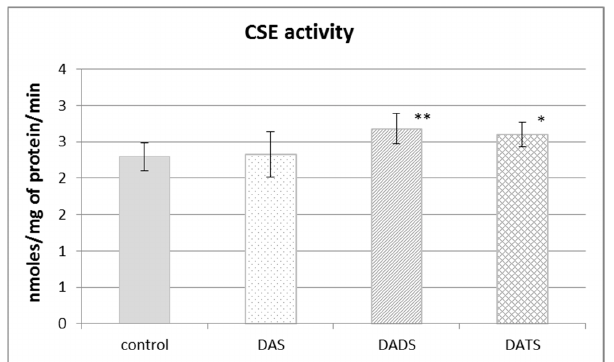
Figure 2. The effect of garlic-derived allyl sulfides (DAS, DADS and DATS) on the activity of γ -cystathionase (CSE). Data represent the means of six animals in each group ± SD and are expressed as nmoles per 1 mg of protein per minute. Each assay was performed in triplicate. Statistically significant differences were determined by ANOVA followed by the Fisher test. * p < 0.05, ** p < 0.01 significantly different from control